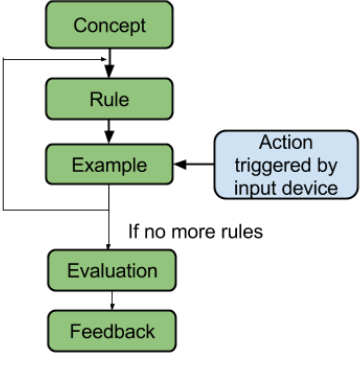
Figure 1. This figure represents an abstract layout for a concept in the soccer course we created. Each box represents an aspect of the course, with evaluation and feedback representing the intelligent portions of the tutoring